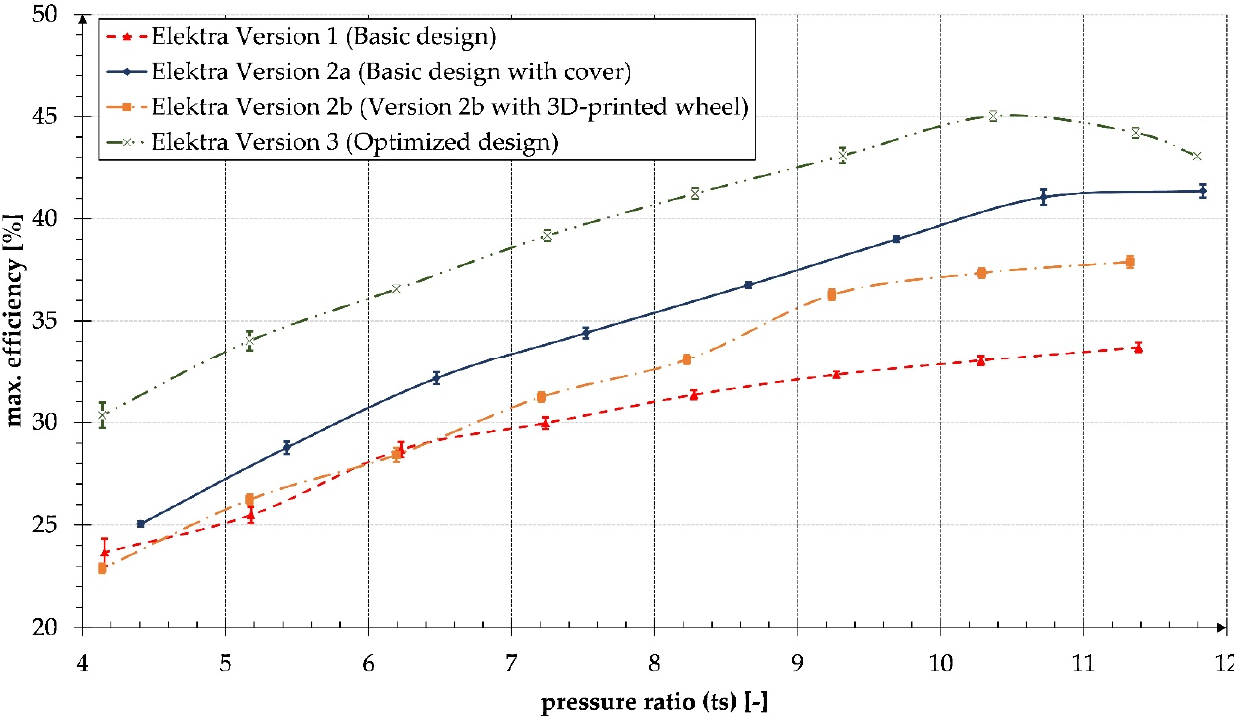
Figure 15. Maximum efficiencies over pressure ratio (PR) for the different Elektra versions.